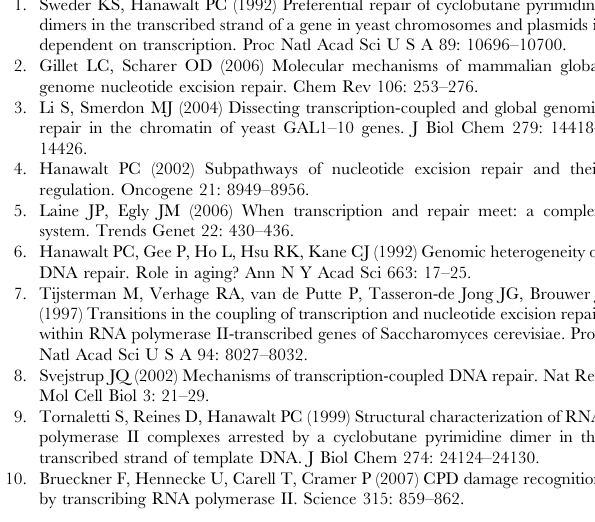
primers specific to ORF1, ORF2 and ORF3 of the RPB2 locus in